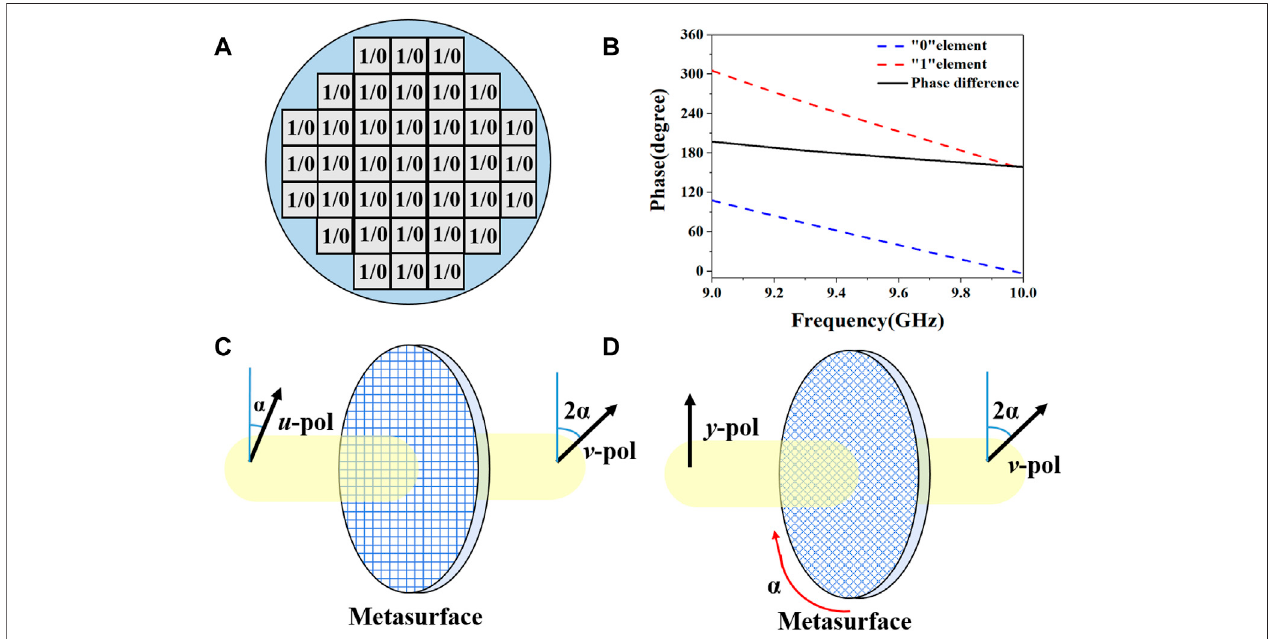
FIGURE1 | A1-bit digital metasurface and coding metasurface. (A) The1-bit digital metasurface iscomposed ofthe “ 1/0 ” elements. (B) The “ 0 ” and “ 1 ” elements in the “ 1/0 ” element and the corresponding phase responses in a range of frequencies. (C) The polarization angle of the transmitted wave is rotated by rotating the polarization angle of the incident wave. (D) The polarization angle of the transmitted wave is rotated by rotating the azimuth angle of the designed metasurface.